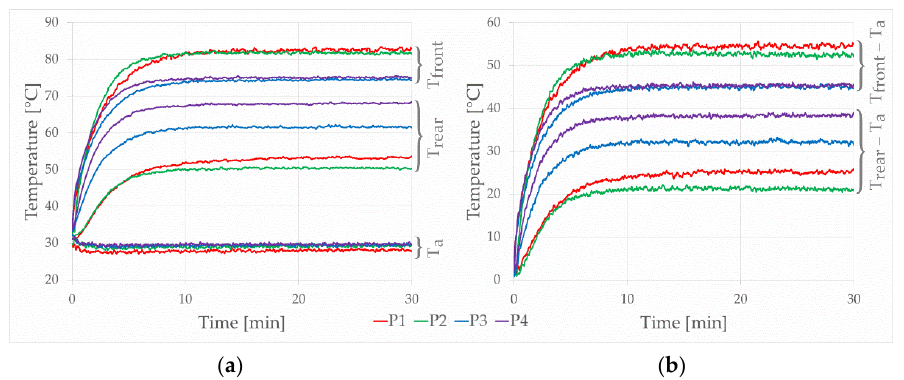
Figure 5. Module ( a ) front, rear, and ambient temperatures ( b ) front and rear temperature related to ambient temperature during tests. Table 6. Front and rear temperature related to ambient temperature at the end of the measurement and time constant for each prototype.